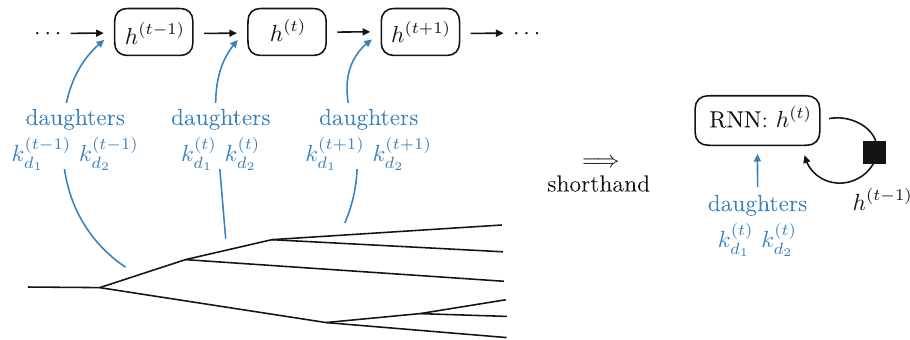
Fig. 3 Information about the clustering tree is embedded in the hidden state h ( t ) of the RNN. For brevity, this recurrent structure is simplified on the right using a shaded box to indicate stepping from t − 1 to t . At each step, the next two daughter momenta emerging in the tree and the previous hidden state h ( t − 1 ) are inputs to the updated hidden state h ( t